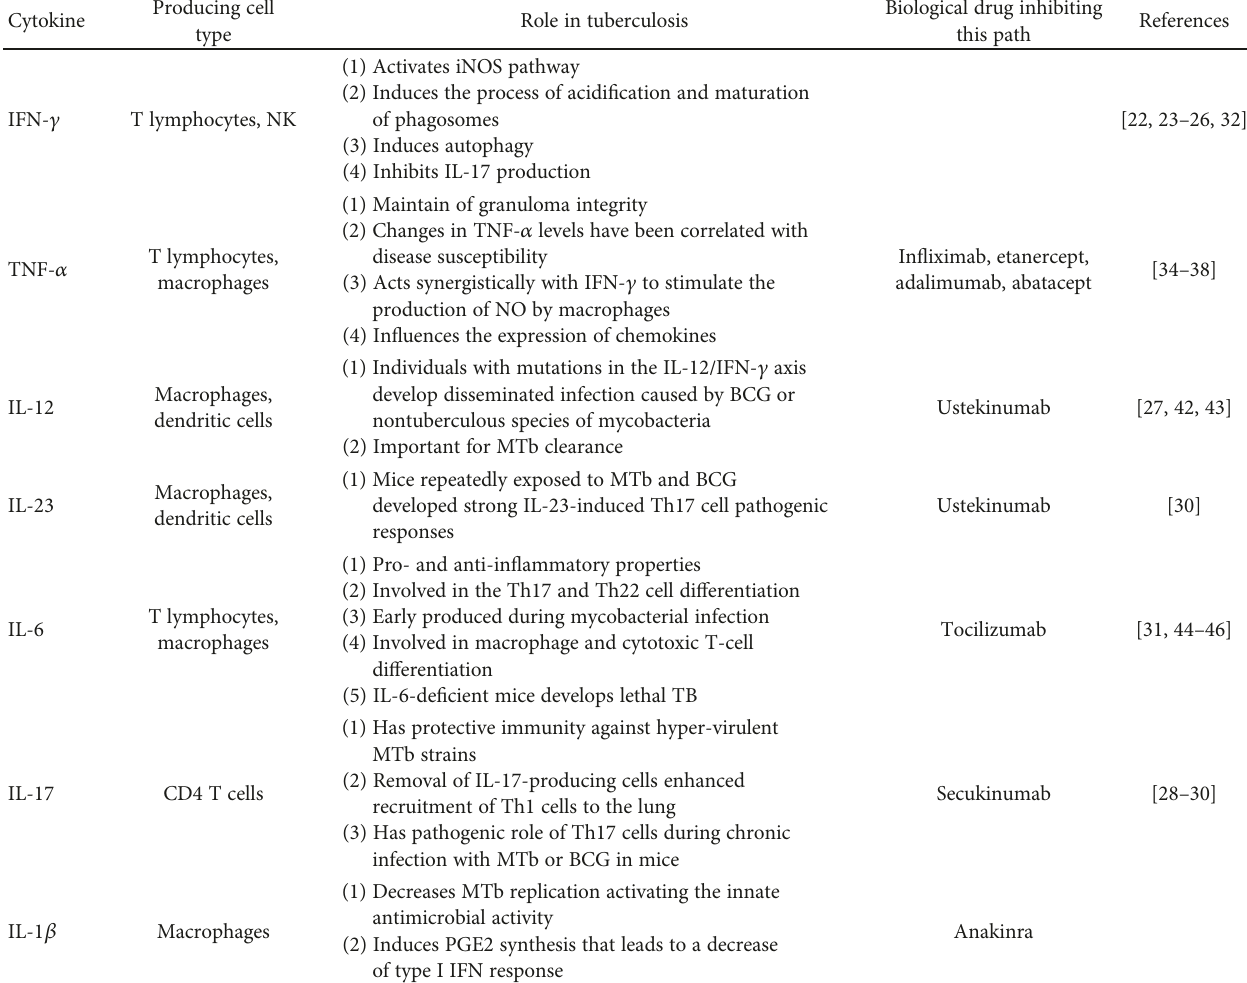
Table 1: Immune cells and factors involved in the immunity against tuberculosis. List of some of the biological drugs used in the treatment of rheumatological disorders that inhibit immune